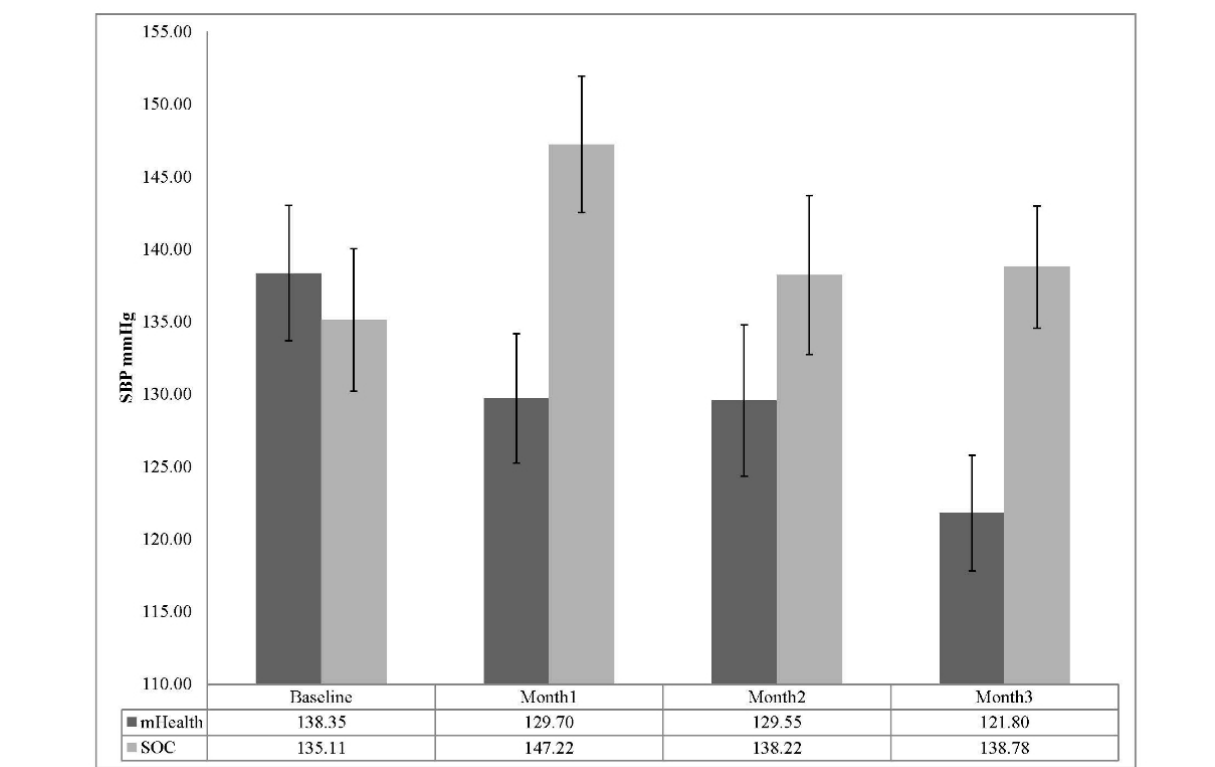
Figure 3. SBP across time by treatment group (mean with Bonferroni 95%